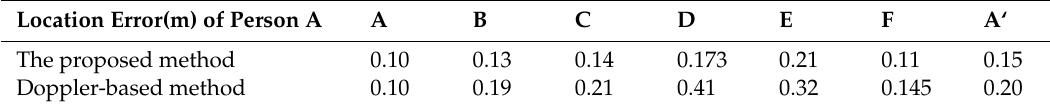
Table 6. Comparison of location errors of Person B.